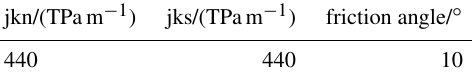
Table 14. Constitutive parameters for